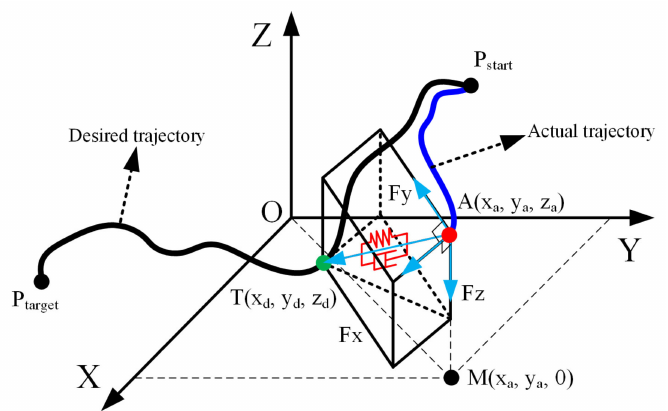
Figure 1. The diagram scheme of the impedance control; the black curve is the desired trajectory, while the blue curve is the actual